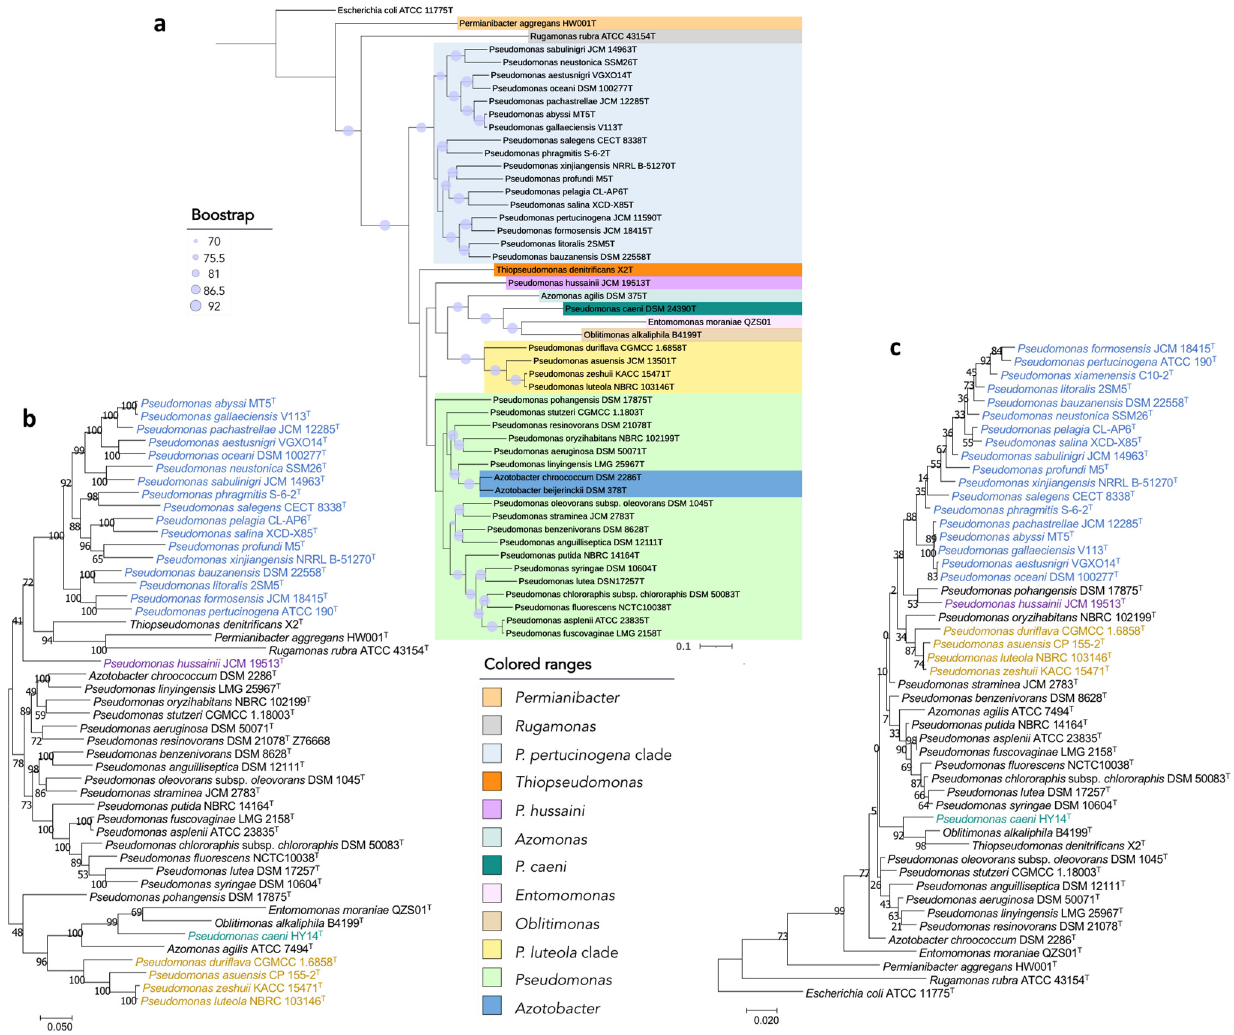
Figure 6. Phylogenetic trees built to study the taxonomic placement of divergent Pseudomonas type strains based on ( a ) 92 housekeeping genes, ( b ) 16S rRNA, gyrB , rpoB and rpoD concatenated genes, ( c ) the 16S rRNA gene. Scale bars = 1 nucleotide (nt) substitution per 100 nt. Blue circles represent bootstrap values, which indicate the number of individual phylogenetic trees of each of the 92 genes that support each branch (Gene Support Index). Bootstrap value of 92 means that the branch is supported by all UBCG phylogenies.